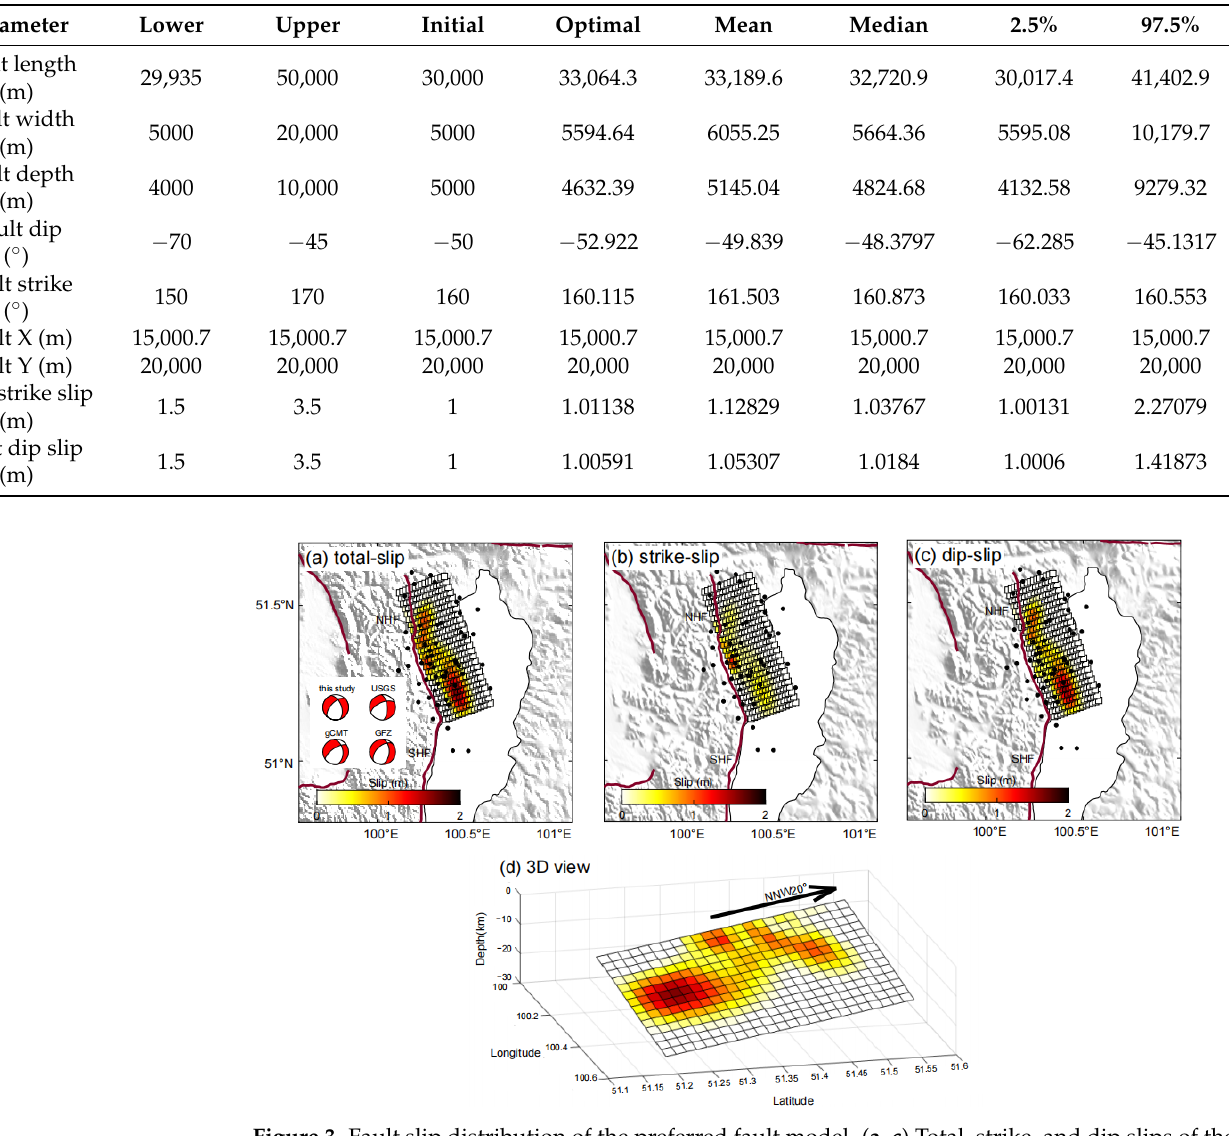
Figure 3. Fault slip distribution of the preferred fault model. ( a – c ) Total, strike, and dip slips of the optimal fault model, respectively. The black dots represent aftershocks within 2 months after the mainshock. The beachballs in ( a ) display focal mechanisms of the Mw6.7 event from this study, USGS, Global CMT, and GFZ. ( d ) The 3D view of the fault slip distribution.